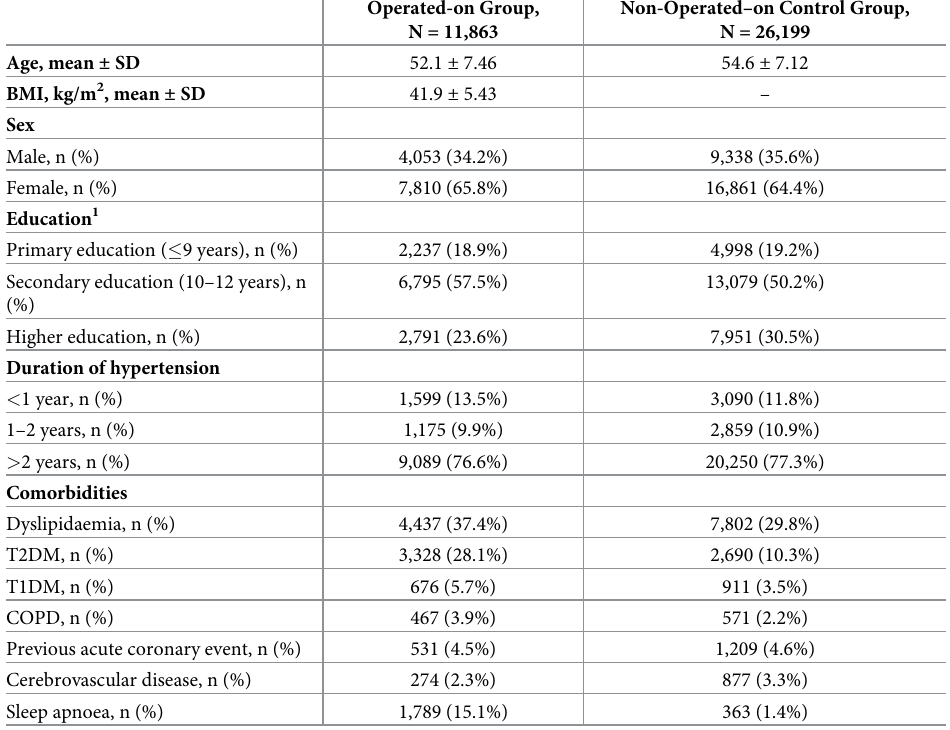
Table 1. Baseline